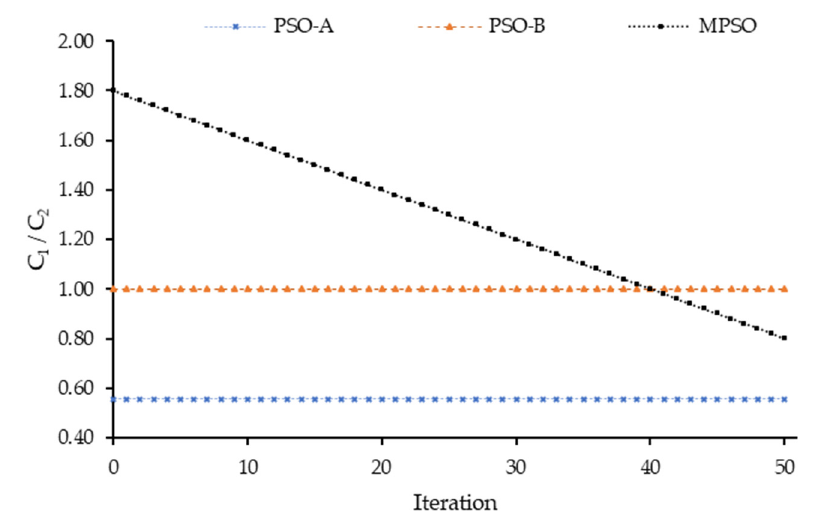
Figure 5. Ratio of acceleration parameters 𝐶 (cid:2869) and 𝐶 (cid:2870) in a runtime.